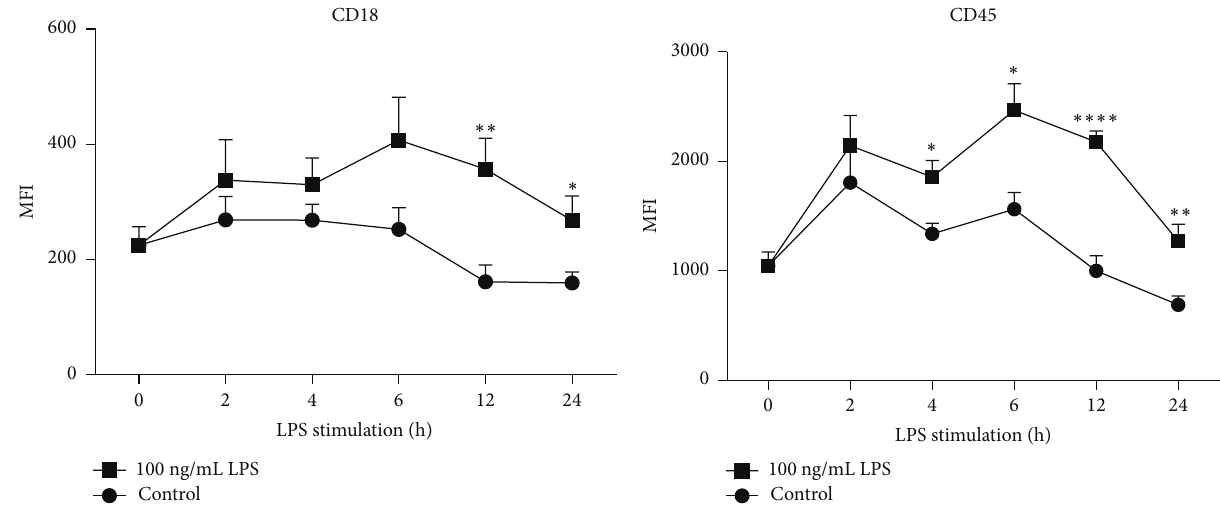
Figure 2: Temporal pattern of degranulation upon LPS stimulation in human neutrophils. Translocation of degranulation markers to the plasma membrane was assessed using flow cytometry after cell treatment with 100 ng/mL LPS for 0h, 2 h, 4 h, 6h, 12h, and 24 h. Sytox Blue negative cells were gated to exclude dead cells from the analysis. Results are expressed in mean fluorescence intensity (MFI) of LPS-stimulated cells and nonstimulated control ± SEM of at least 3 independent experiments, significantly different from nonstimulated control at the same time point: ∗ 𝑝 < 0.05 , ∗∗ 𝑝 < 0.01 , ∗∗∗ 𝑝 < 0.001 , and ∗∗∗∗ 𝑝 < 0.0001